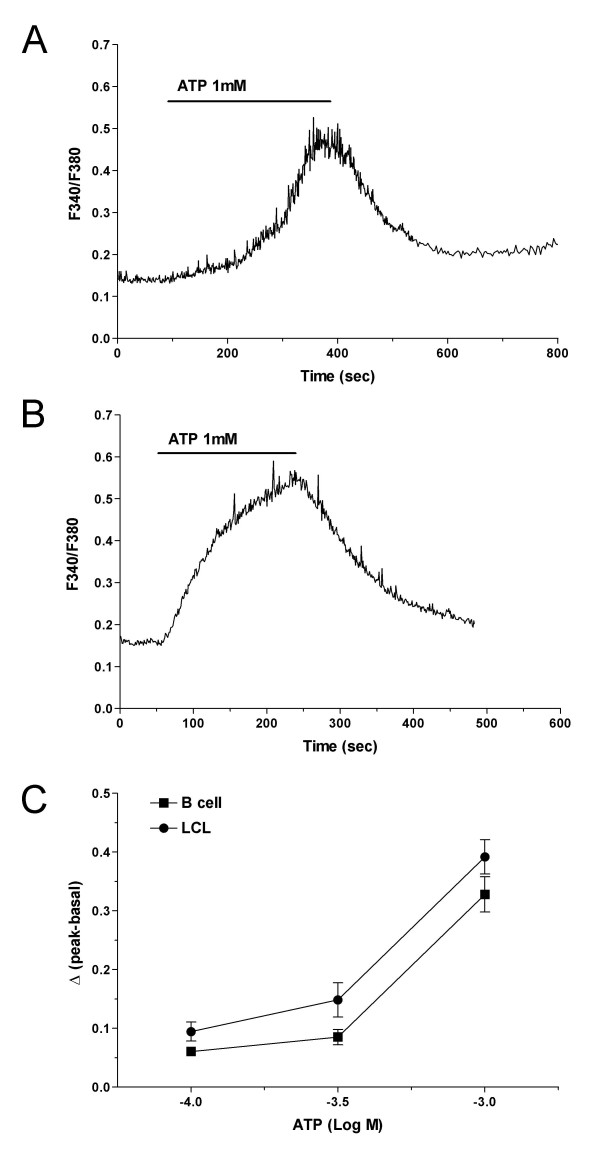
Comparison of ATP-induced increases in [Ca2+]i in B cells and LCLs. (A, B) Average time courses for Ca2+ responses to P2 receptor stimulation with ATP (1 mM) in B cells (A, n = 6) and in LCLs (B, n = 6). ATP was applied as indicated by the horizontal bars above the traces. (C) Concentration-response curve for the increase in [Ca2+]i in response to ATP in B cells and in LCLs (Δratio F340/F380). ATP increased [Ca2+]i in a dose-dependent manner. The maximum increase in the [Ca2+]i over basal is plotted against the concentration of ATP. The measurement of [Ca2+]i was carried out in single cells attached to a coverslip, as described in the Methods section. Data are the mean ± SEM for at least 25 cells on 4 to 5 coverslips.